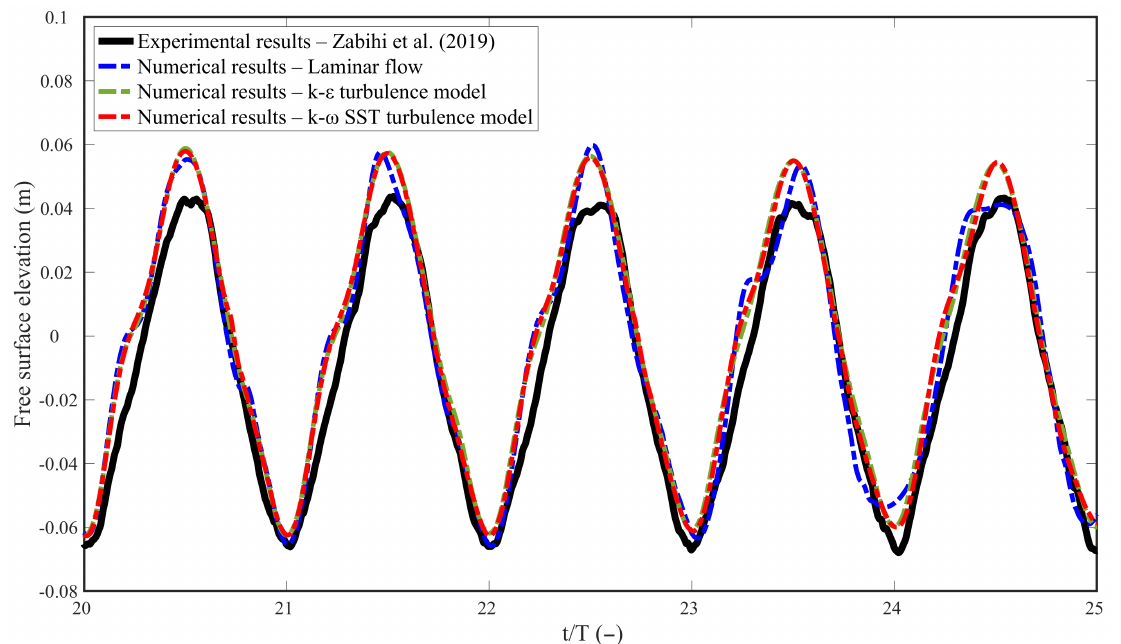
Figure 16. Free surface elevation at wave gauge WG3, located inside the hydropneumatic chamber. Experimental versus numerical results.